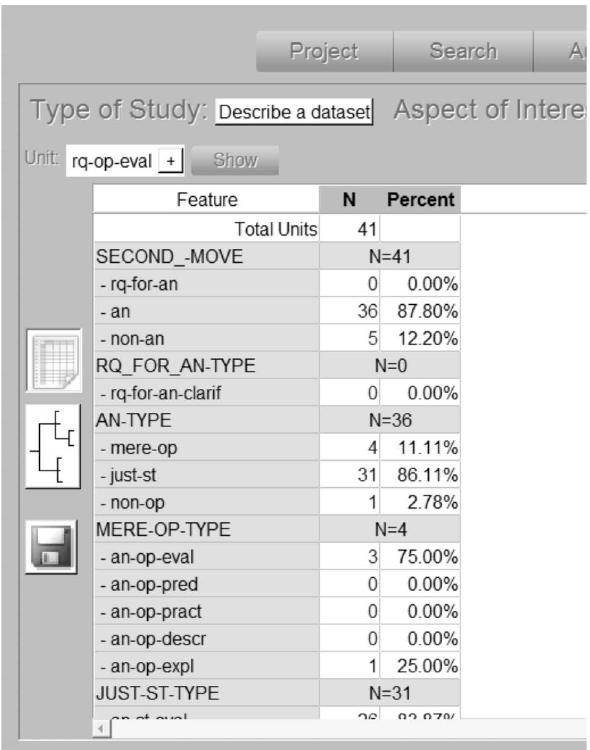
Figure 2. Verification of possible replies to the request for evaluative opinions in financial